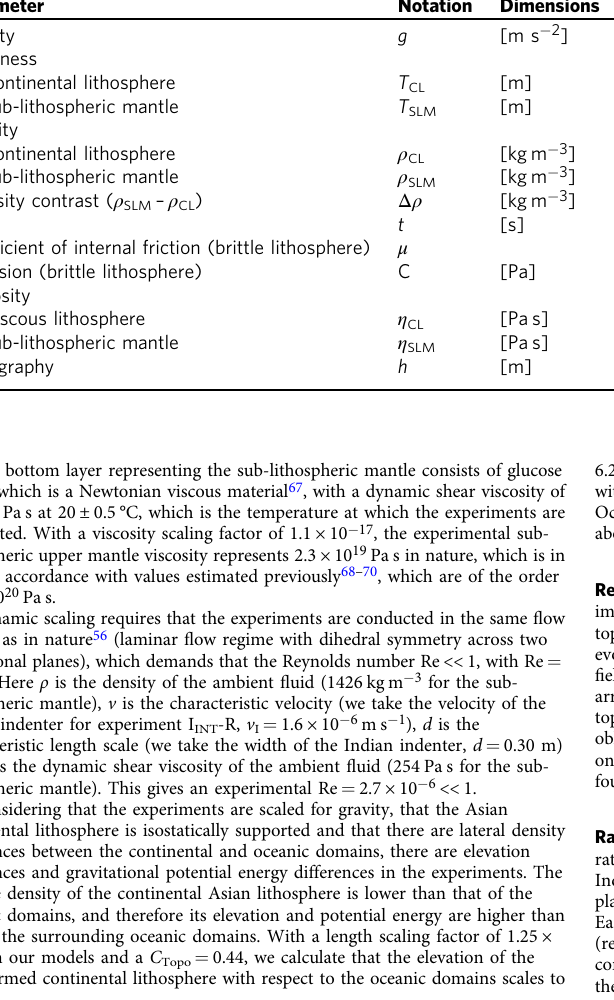
Table 2 Experimental scaling parameters